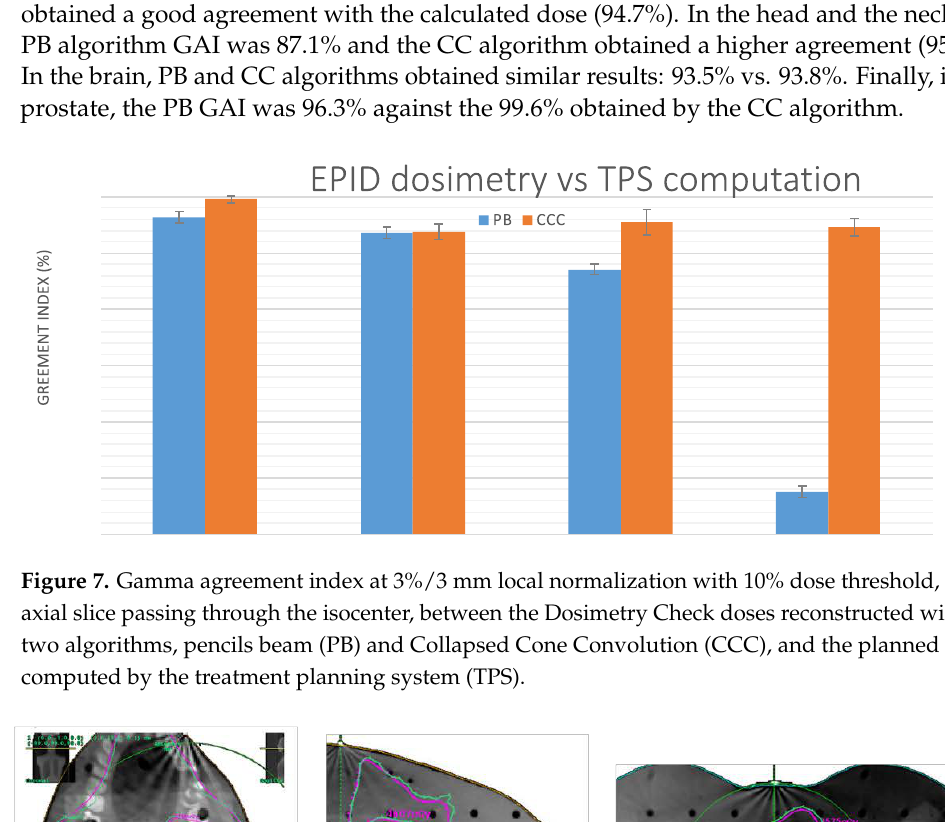
Figure 6. Isodose lines comparison (DC in bold and EBT3 in thin) and map of the gamma values (local, 3%/3 mm, threshold 10%) for the different considered treatment sites and calculation algorithms. ( a ) Brain plan and PB calculation algorithm; ( b ) Brain plan and CC calculation algorithm; ( c ) H&N plan and PB calculation algorithm; ( d ) H&N plan and CC calculation algorithm; ( e ) Lung plan and PB calculation algorithm; ( f ) Lung plan and CC calculation algorithm; ( g ) Prostate plan and PB calculation algorithm; ( h ) Prostate plan and CC calculation algorithm.